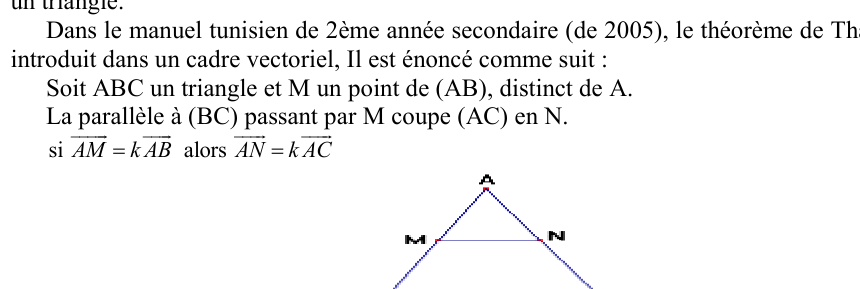
Fig. 3. Conservation du rapport de projection.